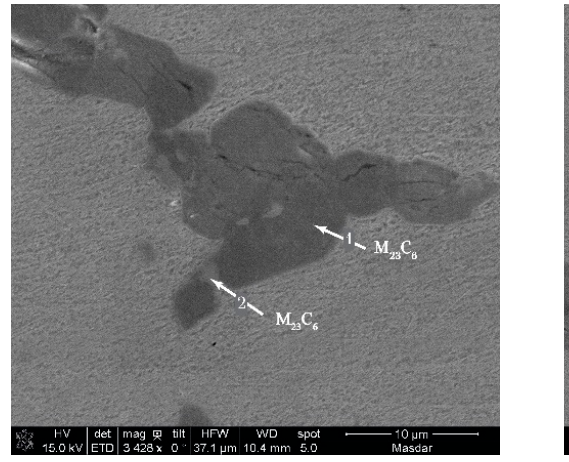
Figure 6. SEM images, ( a , b ), depicting M 23 C 6 carbides in condition H. Numbers indicate EDX composition analysis in Table 2.